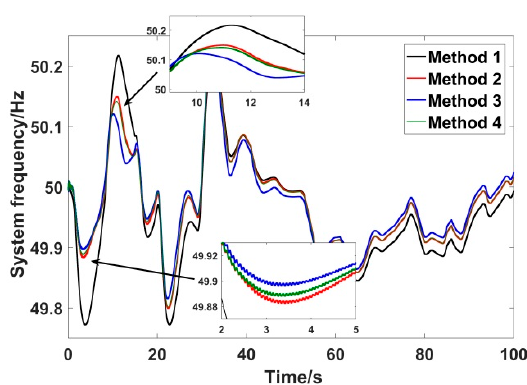
Figure 18. System frequency curves under continuous load disturbance.